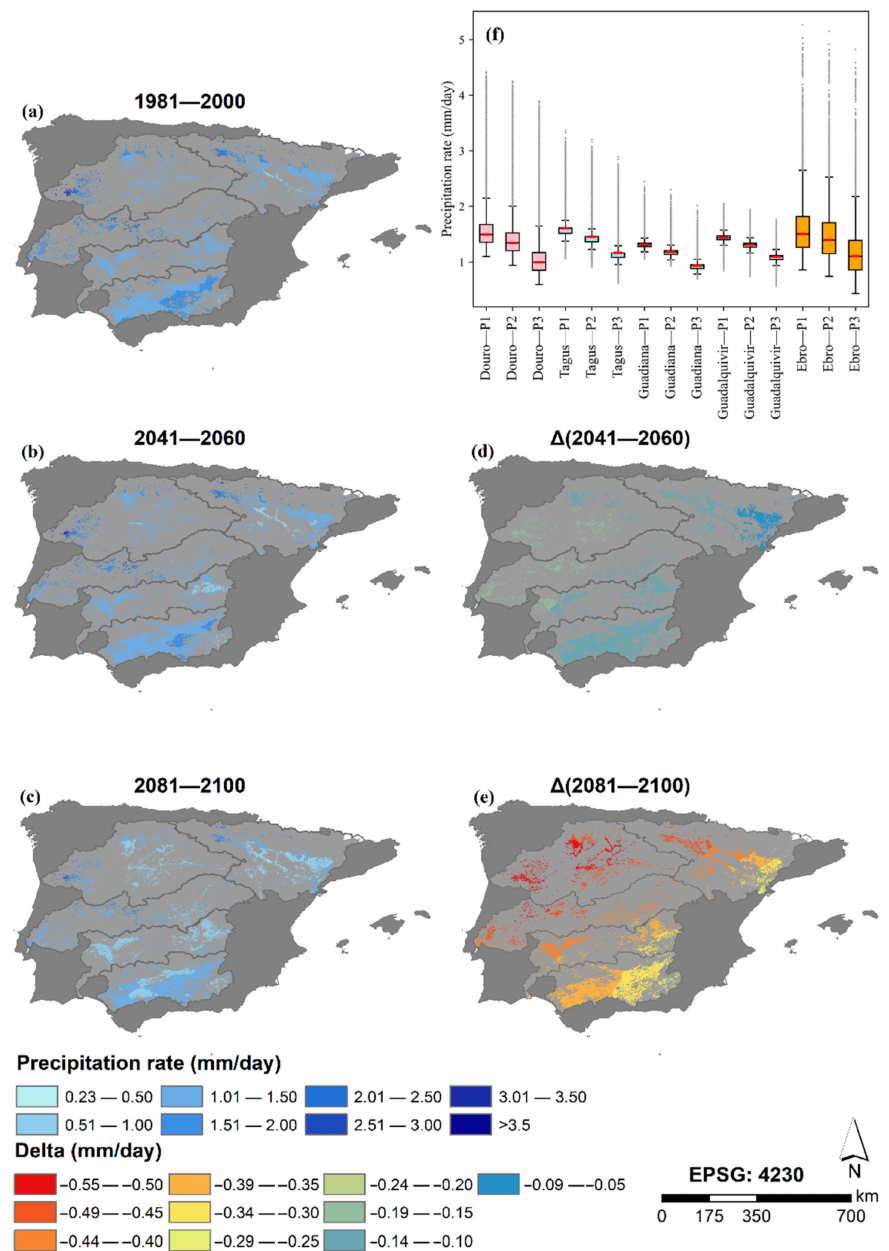
Figure 6. Precipitation rate (in mm/day) in water-dependent areas in the Iberian Peninsula for: ( a ) historical period 1981–2000 (P1), ( b ) 2041–2060 (P2), and ( c ) 2081–2100 (P3), ( d ) P2–P1, ( e ) P3–P1, and ( f ) locality, spread, and skewness for each period and river